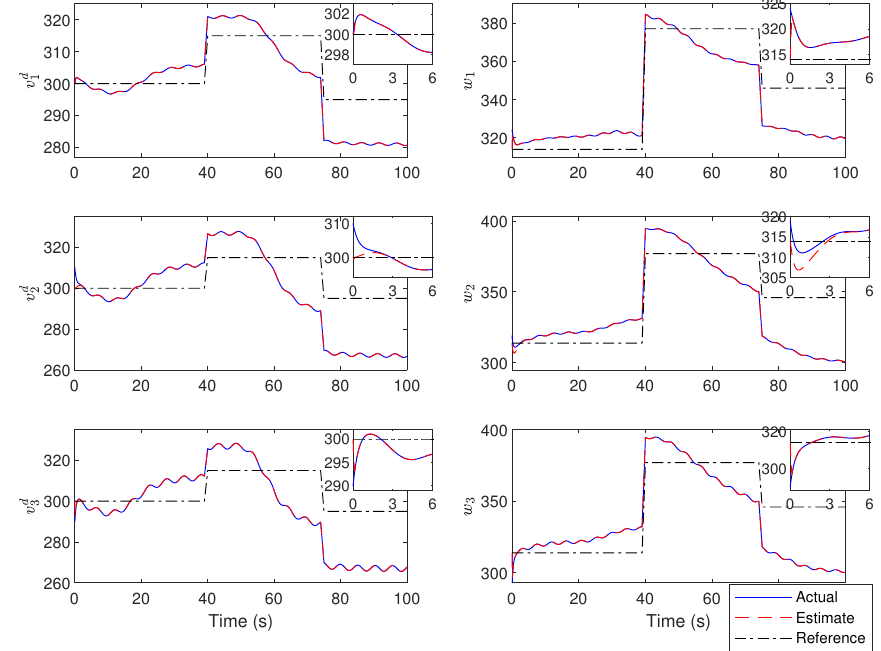
Figure 3. The states of system (53) (solid), their estimates from the central SMO (dashed), and the reference value (dash-dotted) for the case where u cc =